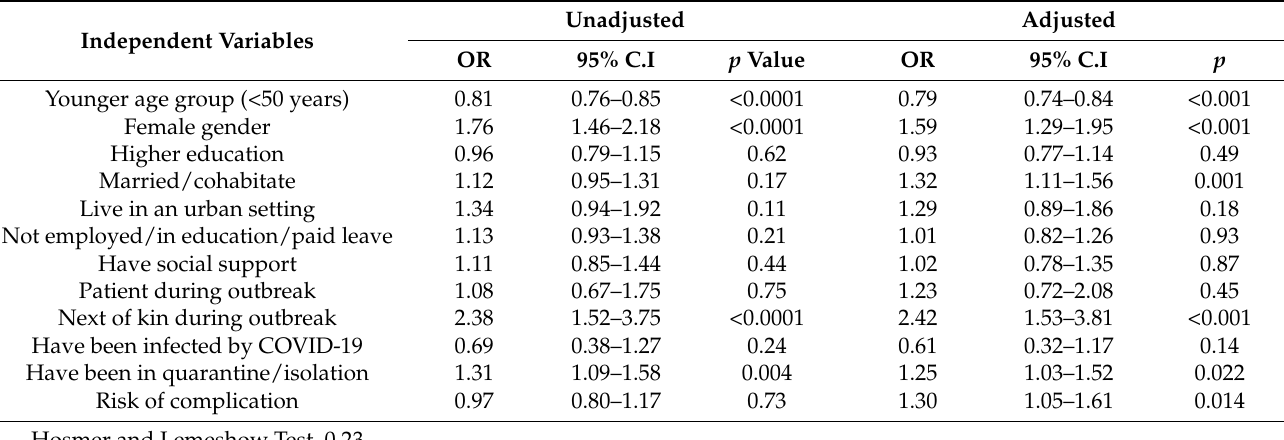
Table 3. Associated factors with being concerned for family and